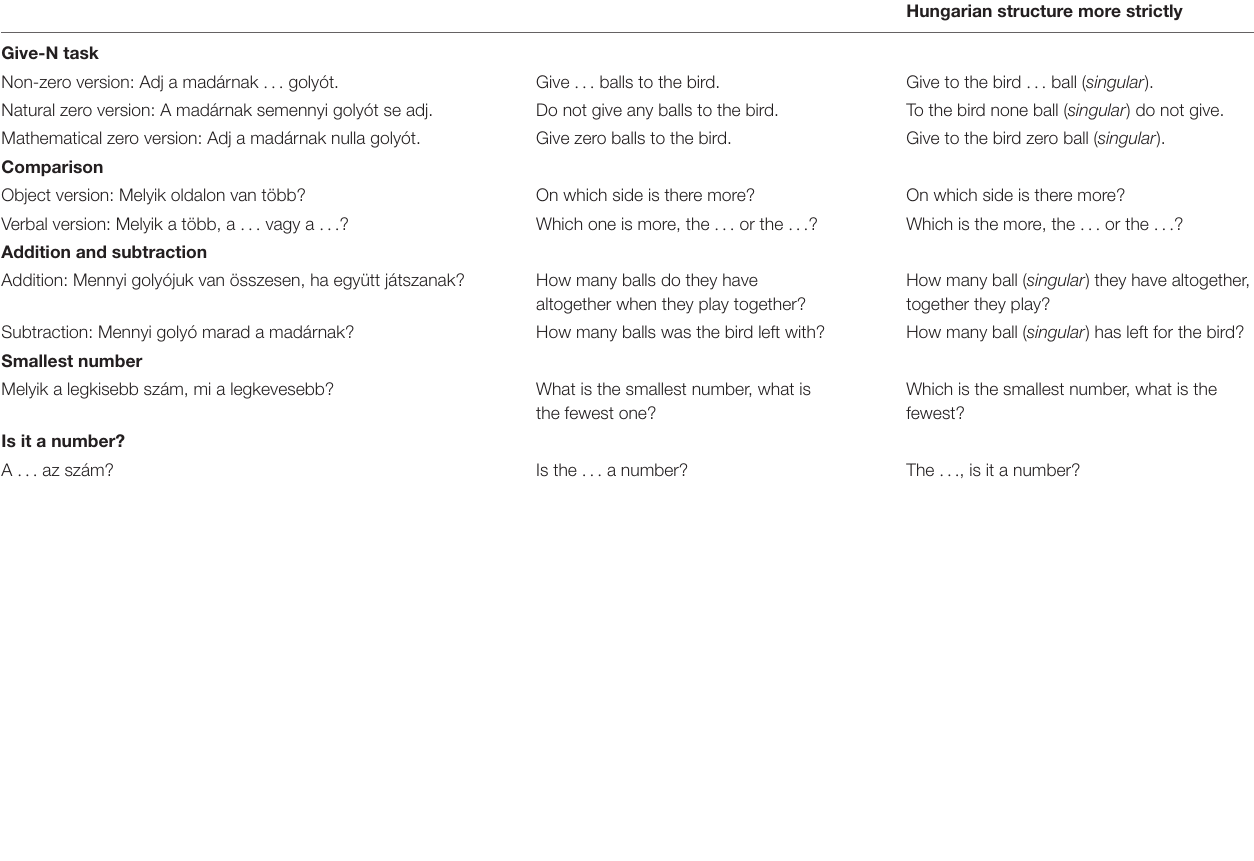
TABLE A1 | The questions in all tasks, in Hungarian and in their English translations. Hungarian version English